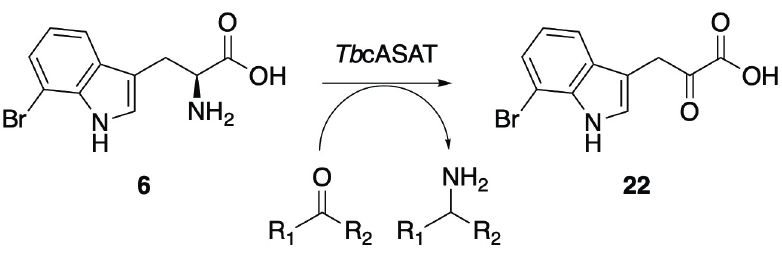
Fig 6. Proposed turnover of substituted tryptophan 6 to its corresponding α -ketoacid 22 by